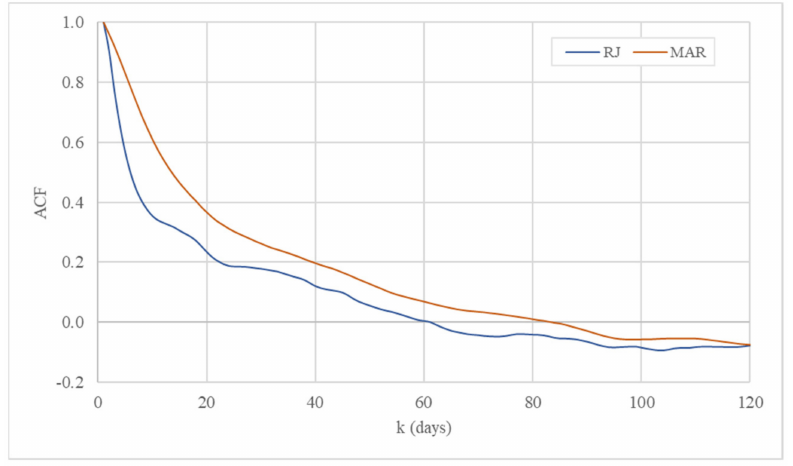
Figure 4. Auto-correlation functions (ACF) of daily discharge series at Rjeˇcina Spring (RJ) and Martinš´cica hydrological station (MAR).